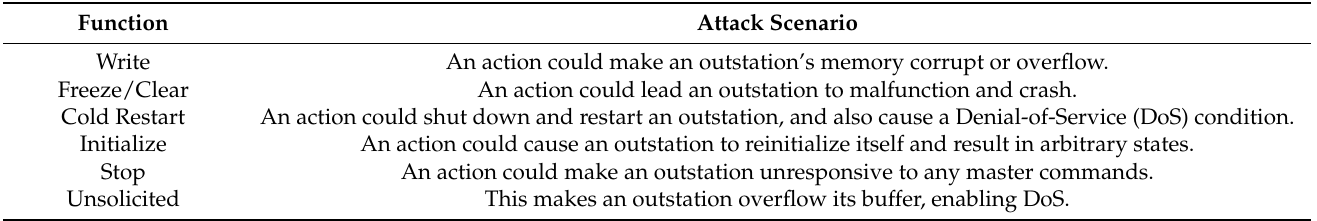
Table 2. DNP3 scenarios of attacks utilizing function